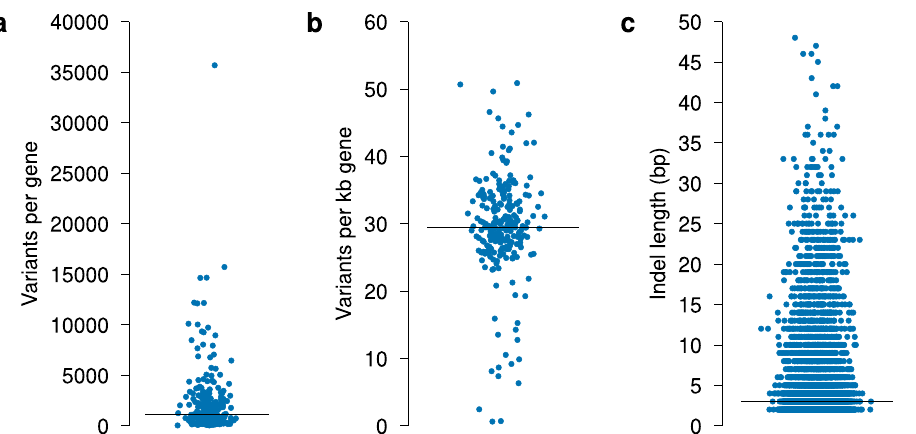
Figure 3. Genetic variation in human GTs. We extracted all genetic variants with rs numbers called by 1000 G. ( a ) Number of variants per GT gene. We found a large variation in the number of variants per GT locus, with an almost 1000-fold difference between the highest and the lowest. ( b ) Number of variants per GT gene, normalised by gene length. ( c ) Distribution of the length of indels in the 1000 G data. Whilst most indels were short (median 3 bp), indels up to 48 bp in length were present. The black bar in the graphs represents the median